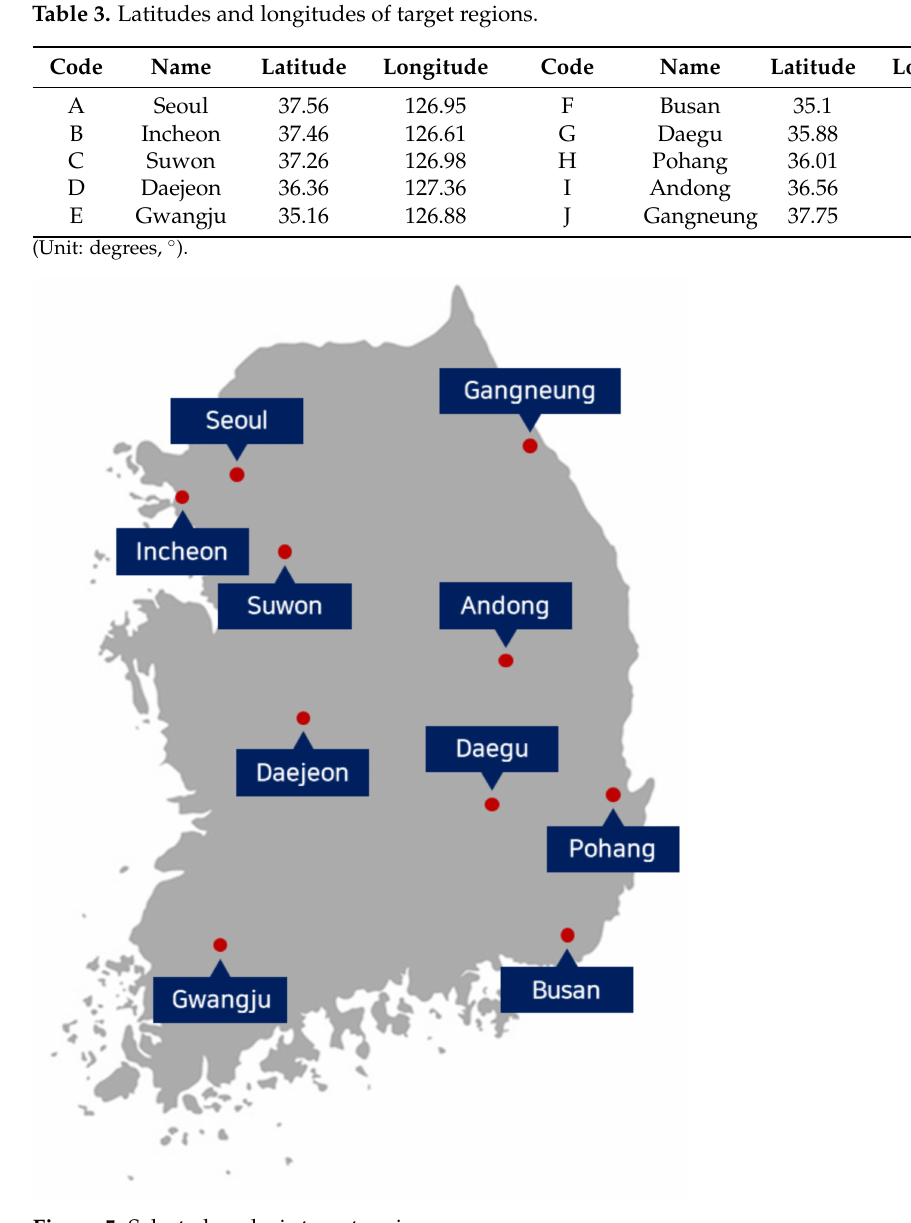
Figure 5. Selected analysis target